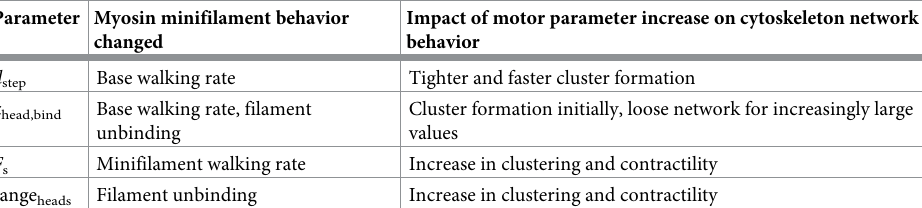
Table 2. Impact of the parameters discussed in § 3.1.2, 3.1.3, 3.1.4, and 3.1.5 on myosin minifilament behavior (MEDYAN model in [17]) and on network-level cytoskeleton organization (this